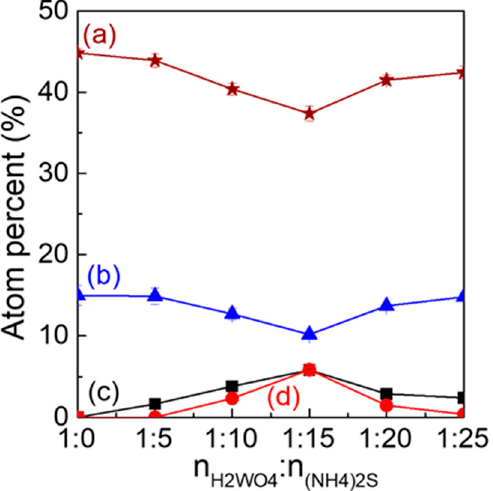
Figure 4. Plots of the contents of (a) O, (b) W, (c) N, and (d) S versus the addition of (NH 4 ) 2 S.